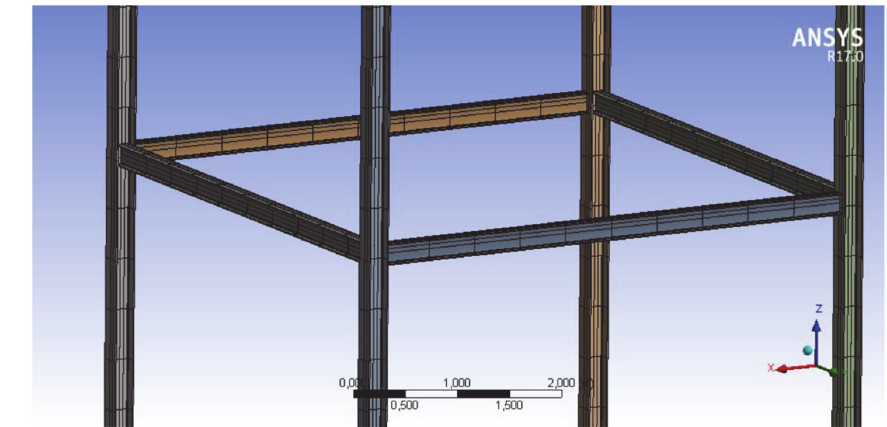
Figure 5: Mesh of the steel